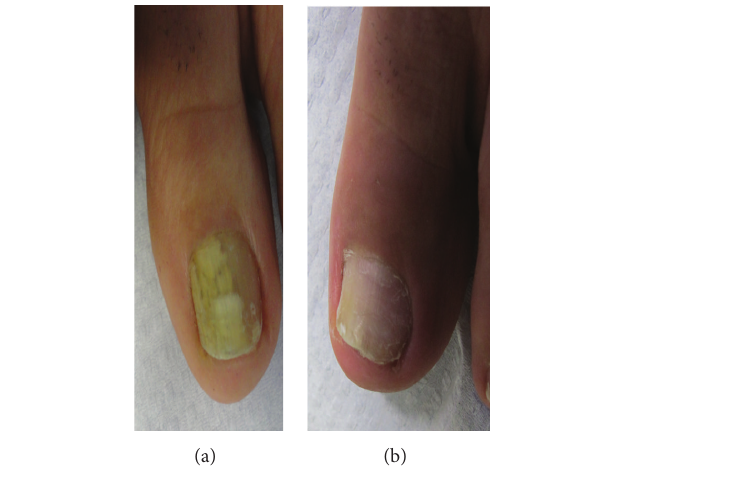
Figure 5: (a) 60-year-old female patient, before treatment. Verticillium sp. was isolated on mycological testing. OSI was 30. (b) After treatment with great improvement. OSI is 4 showing 86.67%